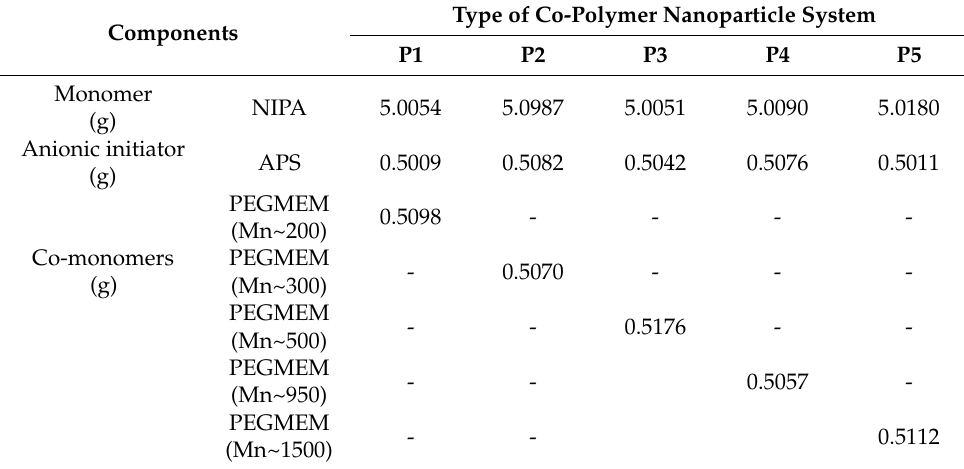
Table 1. Substrates compositions of P1, P2, P3, P4, and P5 nano co-polymers.